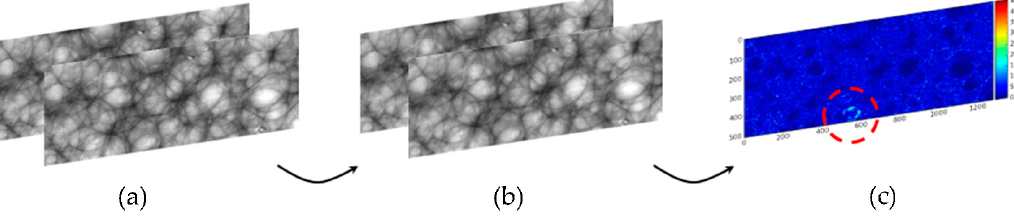
Figure 1. Functionality of the self-written Python program for temporal and spatial detection of ruptures. ( a ) Normalized, flat-field, and dark-field corrected images are ( b ) median filtered; ( c ) Afterwards the absolute intensity difference between two subsequent images is calculated. The resulting color-coded image highlights coalescence.